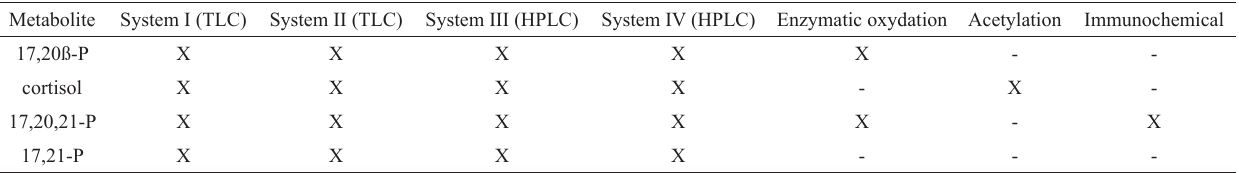
Table 2. Analysis of metabolites produced by testes fragments of three males of Micropogonias furnieri at spermiating time. System I = toluene/cyclohexane 50/50 v/v; System II= benzene/acetone 80/20 v/v; System III = methanol/acetonitrile/water